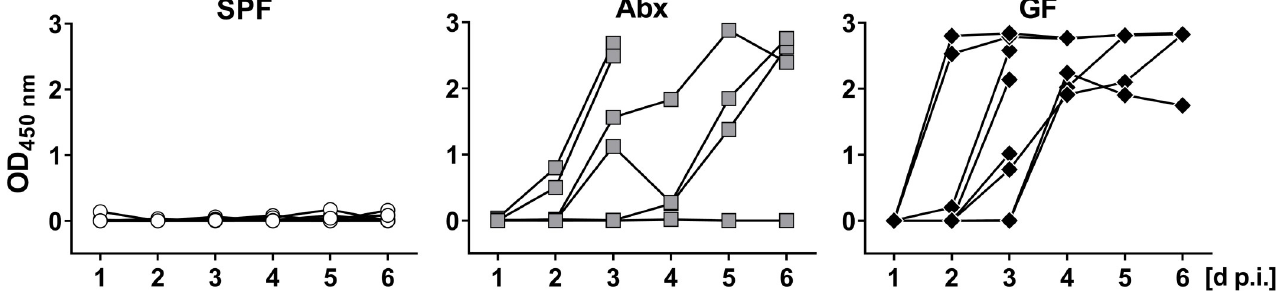
Fig 1. Germ-free and antibiotic-treated mice are highly susceptible to oral infection with rotavirus. Conventional specific pathogen free (SPF, n = 10), antibiotic-treated (Abx, n = 9) and germ-free (GF, n = 8) C57BL/6 mice were infected orally with 2.4x10 4 ID 50 of murine rotavirus strain EDIM. Fecal pellets of individual mice were collected daily and levels of viral antigen were determined by ELISA. Four animals of the Abx and the GF groups were sacrificed on day 3 post-infection for analysis of tissue in the context of a different project.